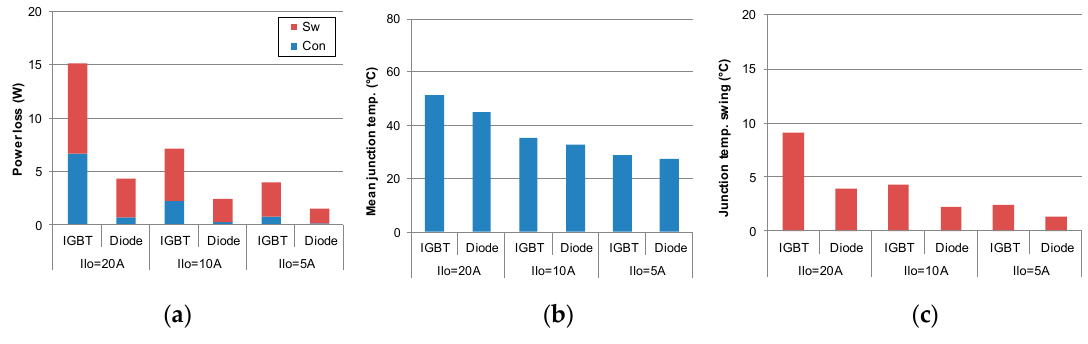
Figure 6. Impact of various loading currents (I lo ) on power module. ( a ) Loss dissipation. ( b ) Mean junction temperature. ( c ) Junction temperature swing.